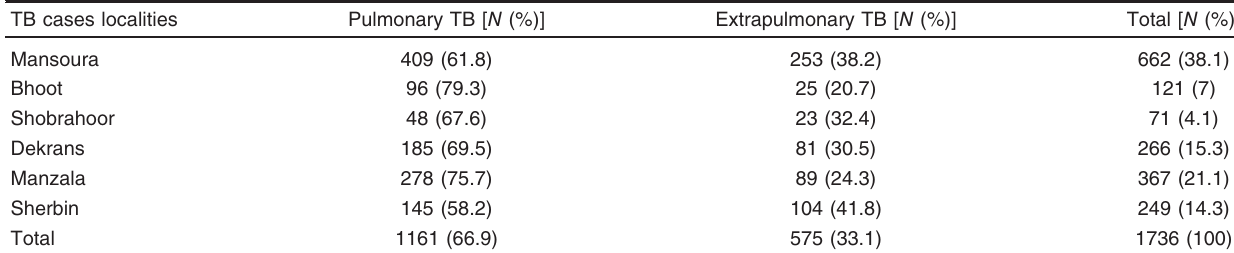
Table 1 Geographical distribution of pulmonary and extrapulmonary tuberculous cases and statistical analysis between both types (2006 – 2011) TB cases localities